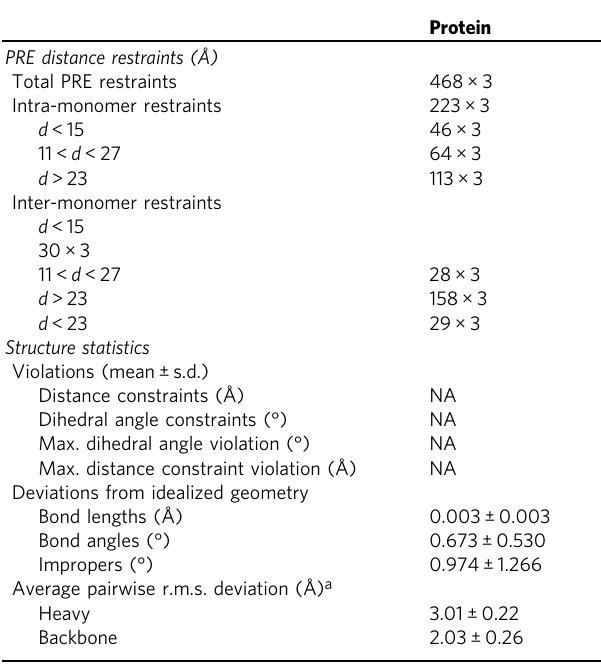
Table 1 PRE distance restraints and re fi nement statistics for protein structures.